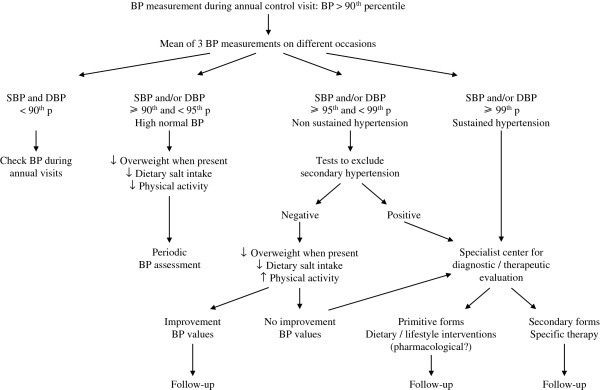
Flow chart for diagnosis and management of hypertension in children and adolescents.